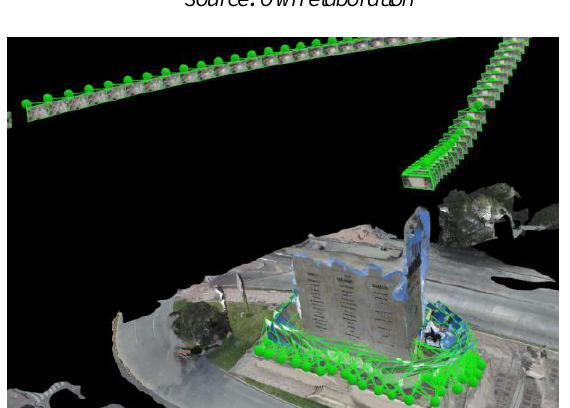
Figure 17: Result of 3D reconstruction from capturing images from the surface and a flight of drone top side view of the sectors in which I miss captures of the drone